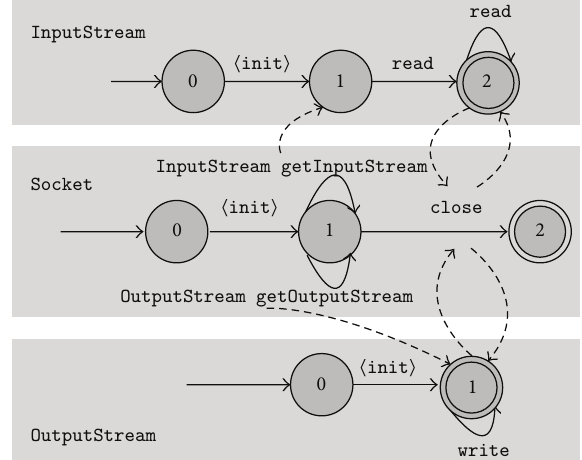
Figure 4: Mined typestates of Socket , InputStream and Out - putStream